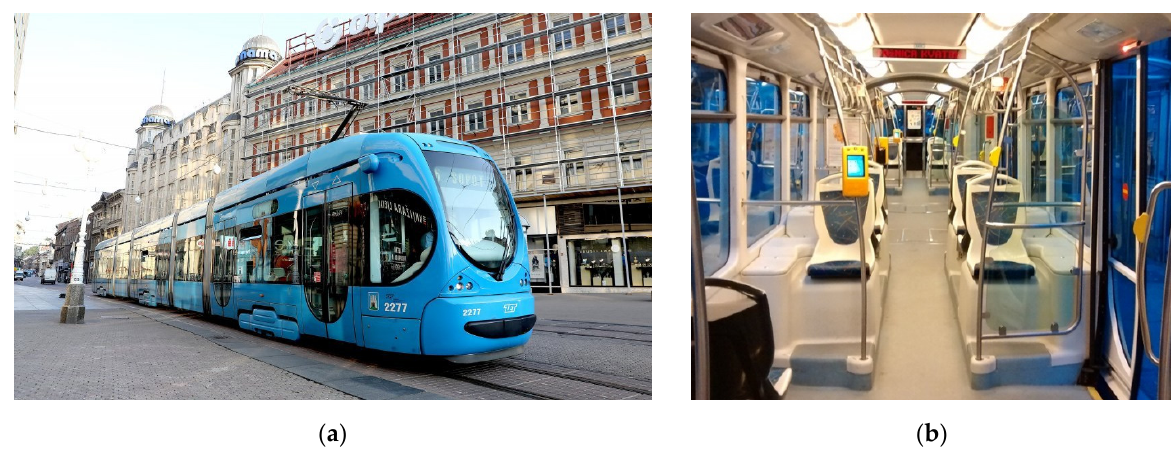
Figure 5. Tram vehicle TMK2200: ( a ) exterior; ( b ) interior.